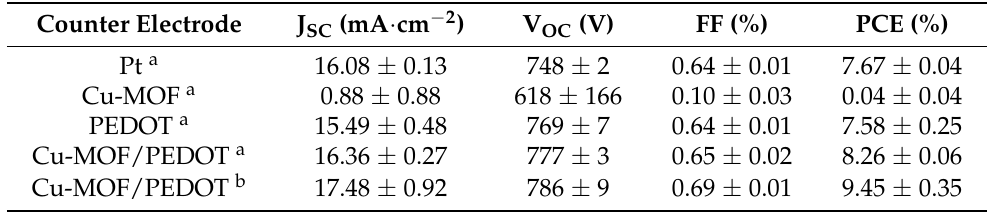
Table 4. Selected photovoltaic parameters using different electrodes. Reprinted with permission from [44]. Copyright 2021 American Chemical Society.